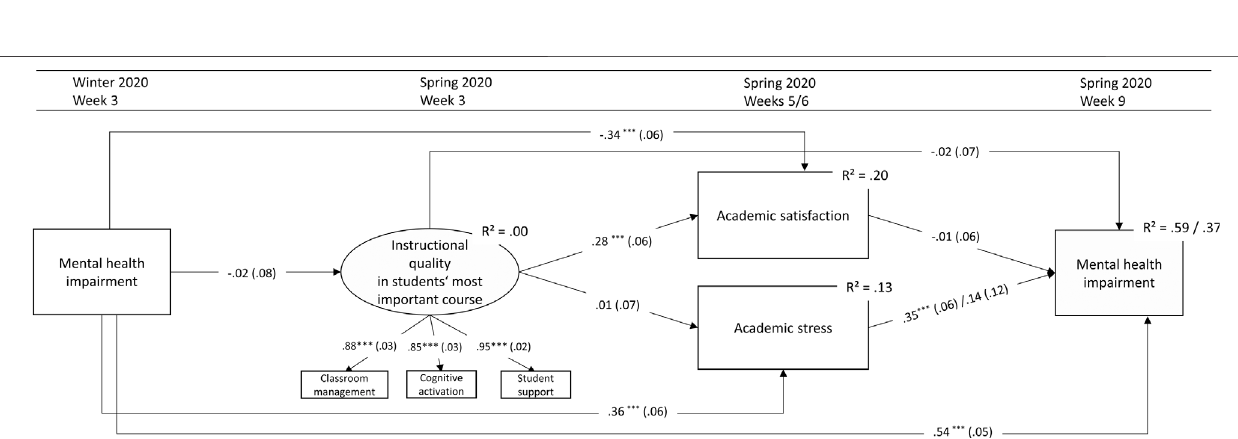
FIGURE 5 | Associations between Instructional Quality in Students ’ most Important Course, Academic Beliefs and Mental Health Impairment Changes Across Gender(ModelB.2). Reported are standardized effects.Genderspeci fi c effects for female ( n (cid:1) 137) and male students ( n (cid:1) 62) are reported if the Wald χ 2 -test indicated meaningfuldifferencesineffects.Theorderofreportedgendereffectsis:female/males.Nogenderdifferencesexistifonlyoneeffectisvisualized. † p < 0.10,* p < 0.05,** p < 0.01, *** p <